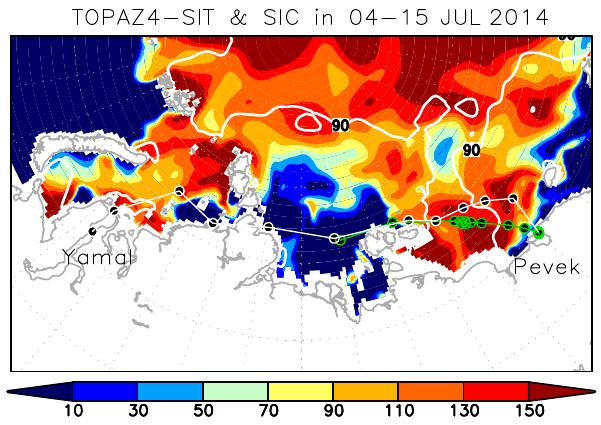
Figure 12. Trajectory of the two tankers over the ESS based on AIS data. The routes cross the ESS from the Laptev Sea on 4 July 2014 to the port of Yamal on 31 July 2014 via the port of Pevek on 20 July 2014. The forward route is highlighted by green circles. The SIT (centimetres; colours) and SIC (%; contours) averaged over the period of the forward route are shown.